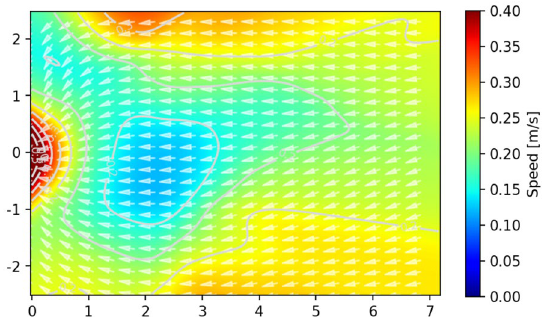
Figure 7. Velocity profiles during the congested state for highly motivated students’ bottleneck experiment (b = 1.05 m) 8 . Color for the speed value, white arrows for the speed directions, and grey lines for speed contours. Note that the bottleneck length (1.9 m) is omitted to better compare with the velocity map of children’s experiments, as we focus on the velocity inside the artificial room.